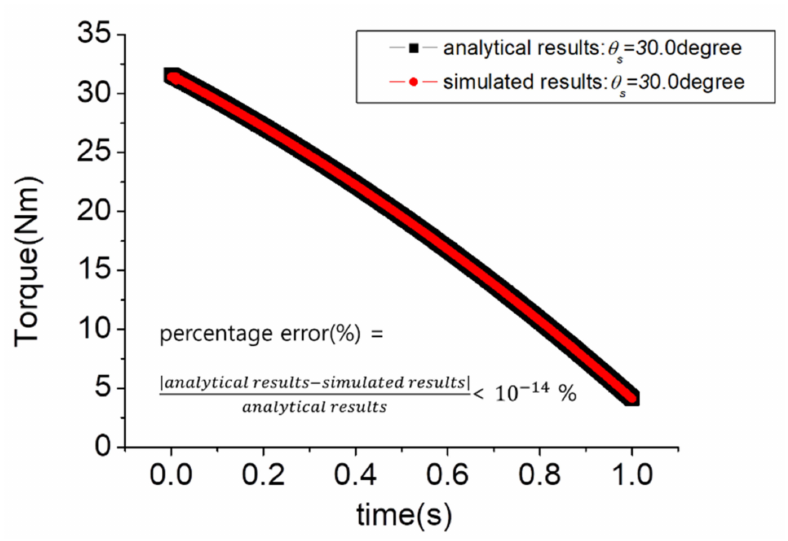
Figure 6. Comparison of analytical and simulated